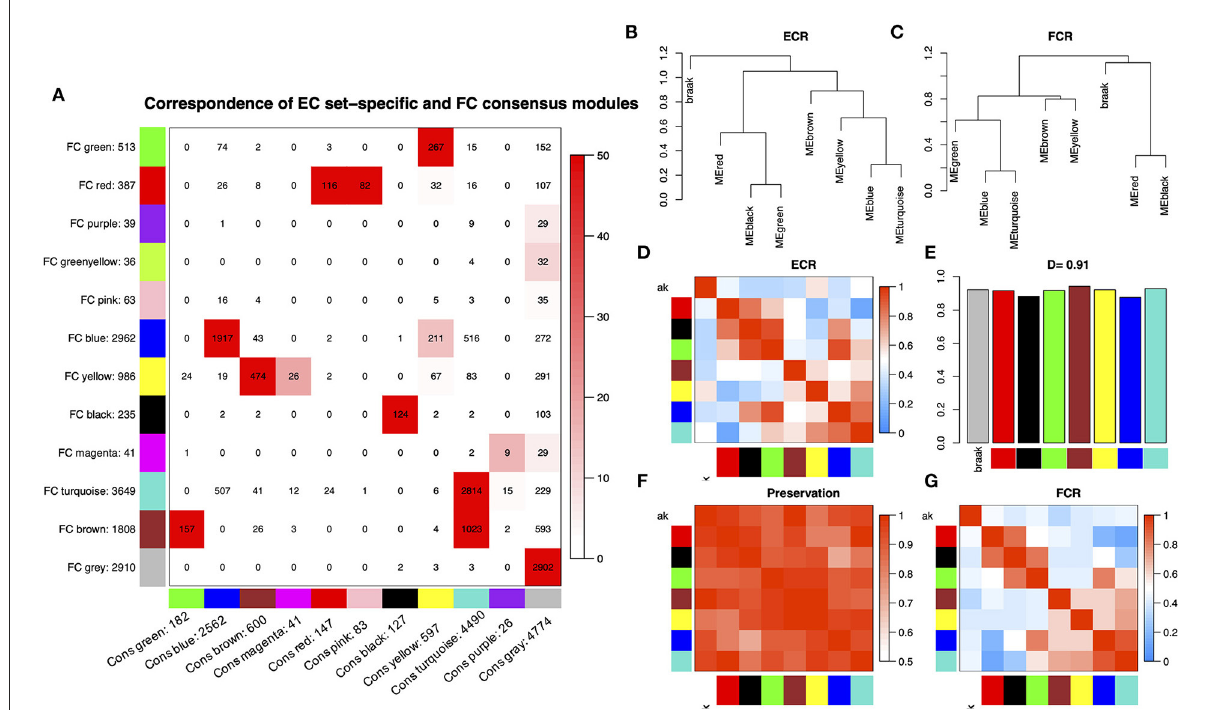
FIGURE1 (A) Comparison between EC set-specific modules and EC-FC consensus modules of the global co-expression network . The numbers in the table represent genes that are shared between EC modules and consensus modules. The color code of the table is -log(p), where p is the p -value of Fisher’s exact test of the overlap of the two modules. The darker the red, the more pronounced the overlap. (B,C) Clustering dendrograms of consensus module eigengenes for identifying meta-modules show the presence of similar major branching patterns in the EC and FC eigengene network. (D,G) The heatmap shows the eigengene adjacencies in EC and FC eigengene networks. Each row and column correspond to an eigengene tagged by consensus module color. Within each heatmap, red represents high adjacency (positive correlation) and blue represents low adjacency (negative correlation) as represented by the color legend. (E) Bar plot shows the preservation degree of each consensus eigengene as the height of the bar (y-axis) where each colored bar corresponds to the eigengene of the associated consensus module. The high-density value D (Preserve EC, FC) = 0.91 indicates the high overall preservation between the EC and FC networks. (F) Adjacency heatmap of the preservation network between EC and FC consensus eigengene networks. The saturation of the red color indicates a correlation preservation of EC and FC module